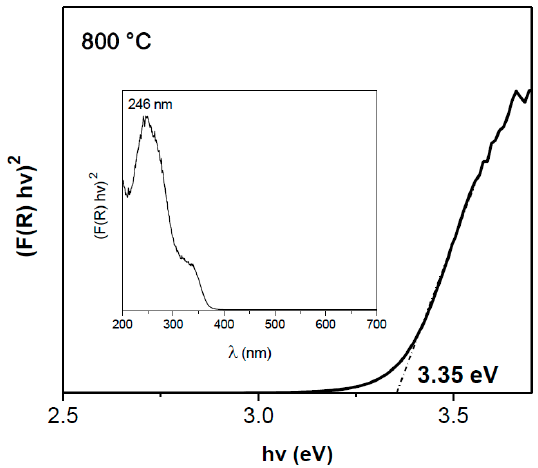
Figure 9. Kubelka–Munk modified spectra and their equivalence in h ν vs λ (insert) of CeO 2 powders thermally treated at different temperatures.